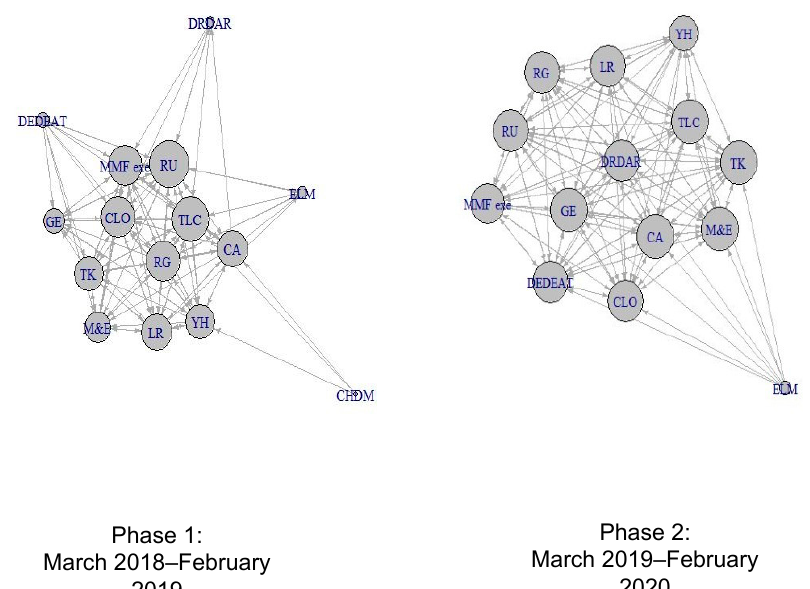
Figure 8. Overview of the information-sharing network. Arrows represent directed, weighted ties and circle size represents degree centrality. Rhodes University (RU), Department of Economic Development, Environmental Affairs, and Tourism (DEDEAT), Department of Rural Development and Agrarian Reform (DRDAR), Chris Hani District Municipality (CHDM), Emalahleni Local Municipality (ELM), Traditional Leaders Council (TLC), Masibambisane multi-actor forum executive (MMF exe), GEF5 Community liaison officers (CLO), Conservation Agriculture Hub (CA), Land Rehabilitation Hub (LR), Rangeland Management Hub (RG), Training and Knowledge Hub (TK), M&E Hub (M&E), Gender Equity Hub (GE), and Youth Hub (YH).